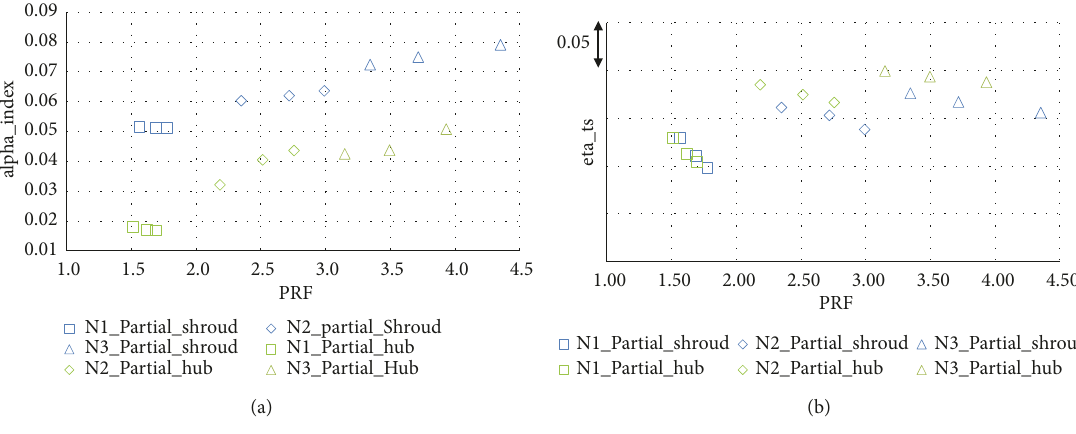
Figure 15: (a) Alpha index and (b) total-to-static efficiency vs PRF.